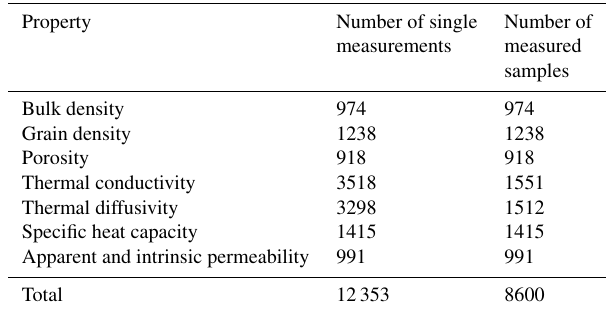
Table 1. Number of measurements of thermophysical properties. Table 2. Number of measurements of rock mechanical